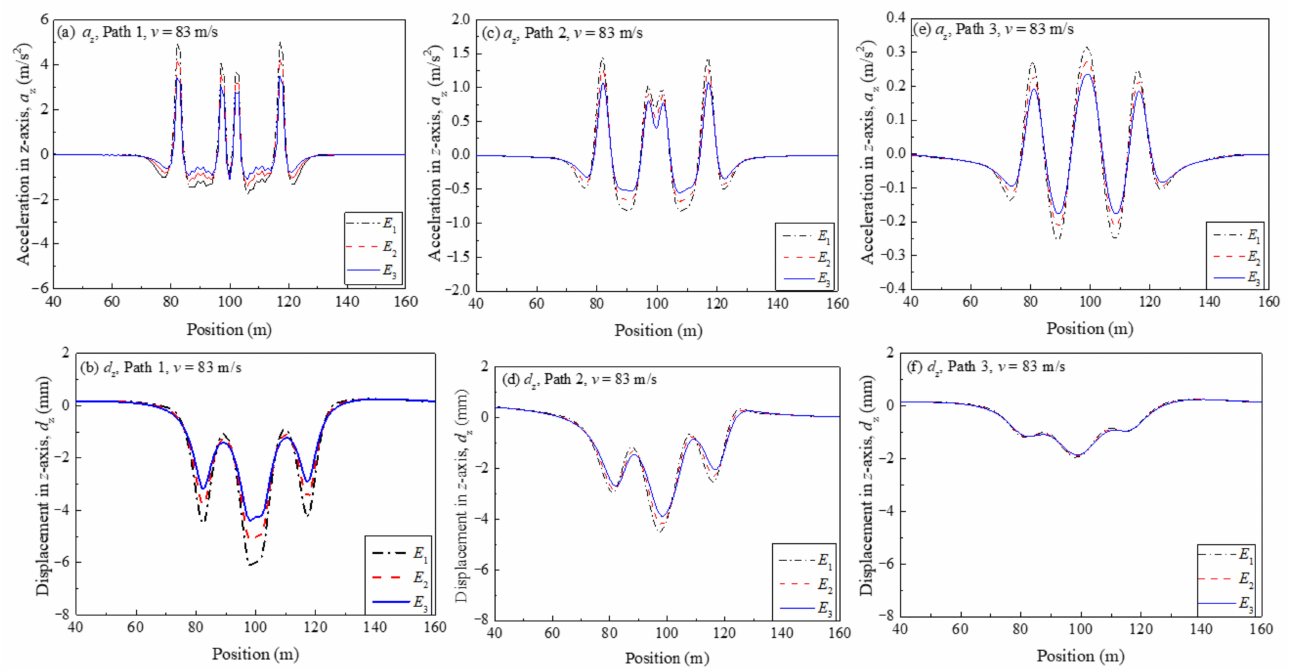
Figure 15. Changes in a z and d z with the embankment stiffness in different paths: ( a ) a z in Path 1; ( b ) d z in Path 1; ( c ) a z in Path 2; ( d ) d z in Path 2; ( e ) a z in Path 3; ( f ) d z in Path 3.